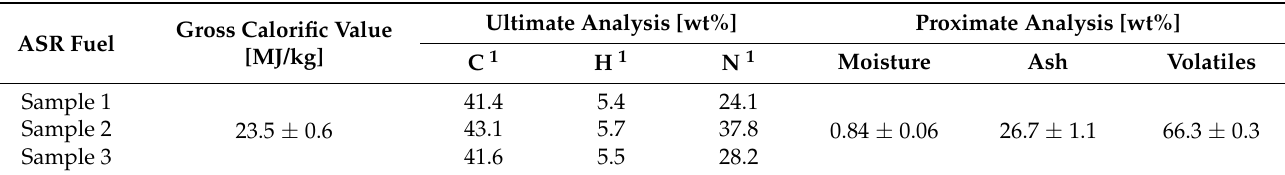
Table 2. Characterization of ASR from automotive plastics.